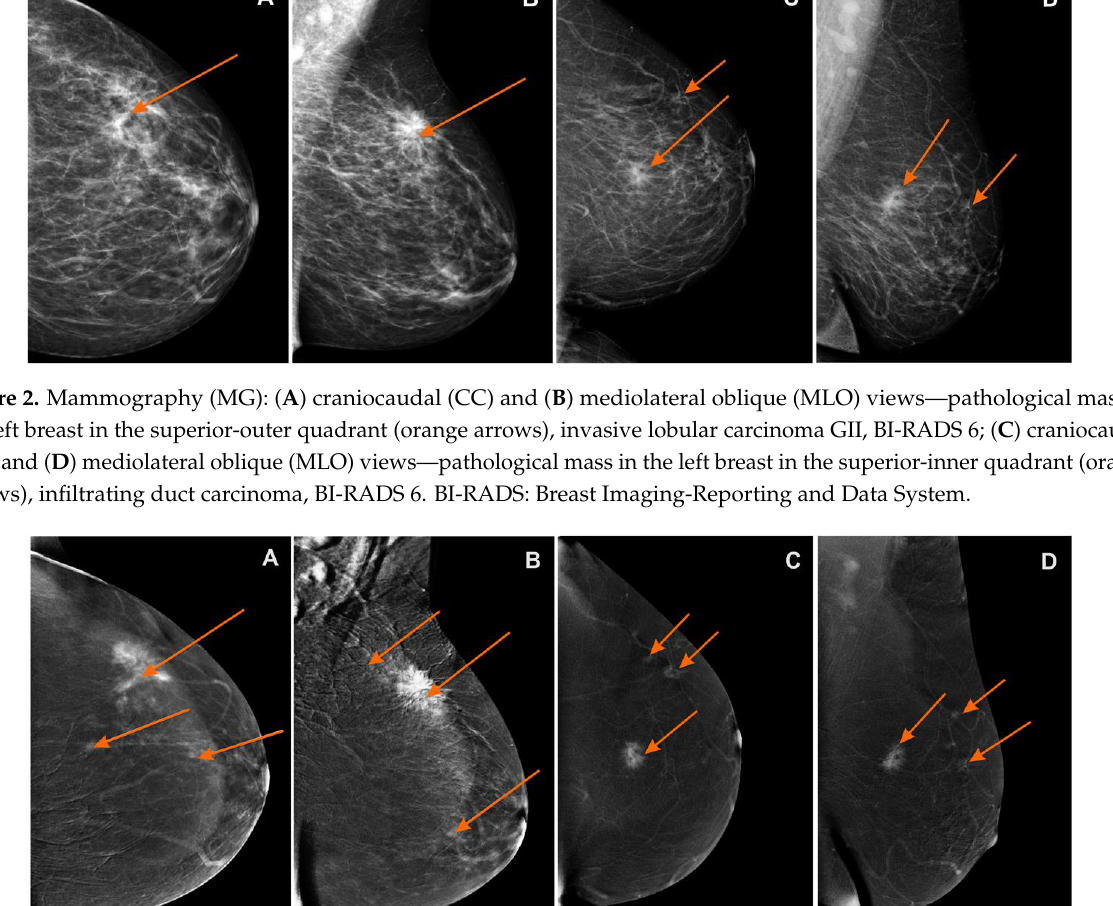
Figure 4. Magnetic resonance imaging (MRI) subtraction image ( A , B ) 2 min after contrast injection irregular mass with heterogeneous enhancement BI-RADS 6 with numerous foci of contrast uptake showing multicentric cancer BI-RADS 4 (orange arrows); ( C , D ) MRI subtraction image 2 min after contrast injection irregular mass with heterogeneous enhancement BI-RADS 6 with additional foci of contrast uptake showing multicentric cancer BI-RADS 4 (orange arrows). 2.3. Contrast-Enhanced Spectral Mammography (CESM)Protocol All CESM examinations were carried out with a digital mammography device dedi- cated to performing dual-energy CESM acquisitions (SenoBright, GE Healthcare, Waukesha, WI, United States). An intravenous injection of 1.5 mL/kg of body mass of non-